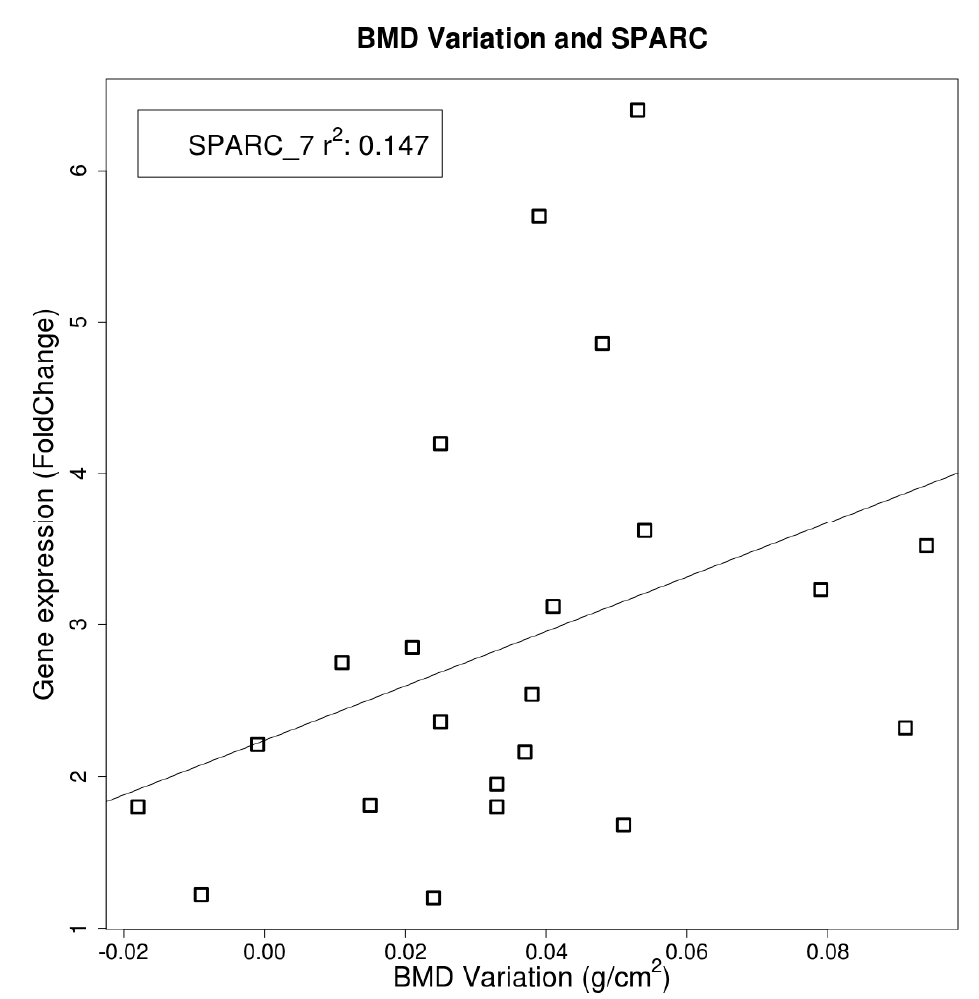
Figure 4. Linear correlation between lumbar spine bone mineral density (BMD) and SPARC gene expression levels (represented as fold change). The correlation was statistically significant ( p < 0.05).